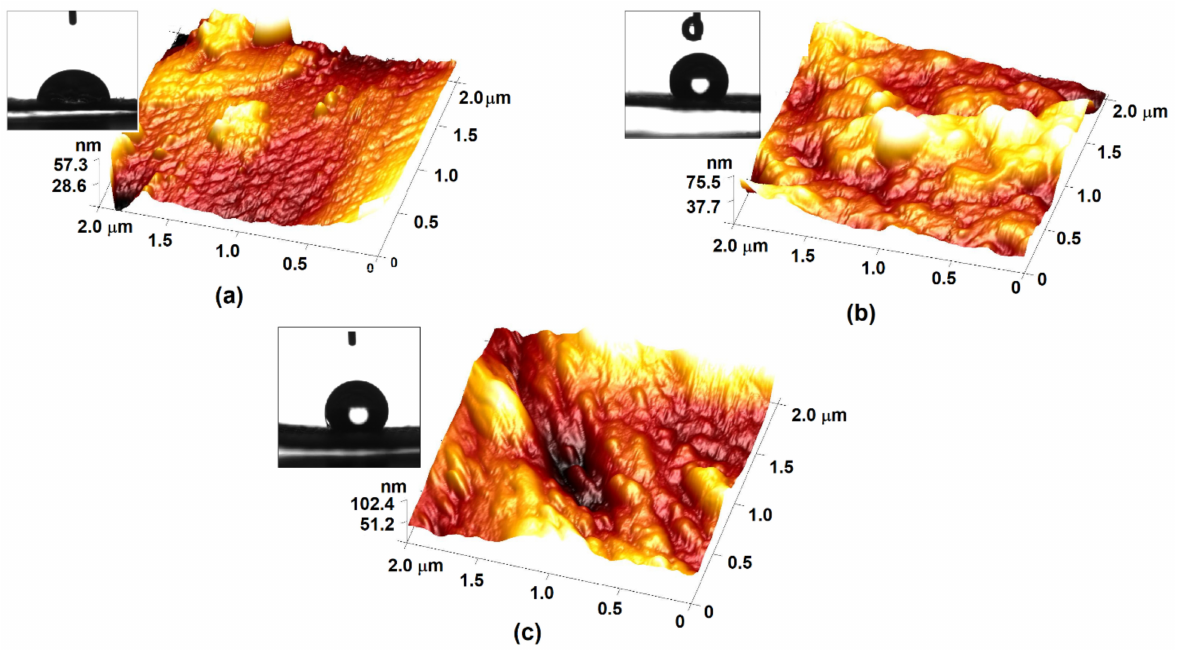
Figure 5. Topography AFM images and contact angle of water on P1 ( a ), P3 ( b ) and P4 ( c